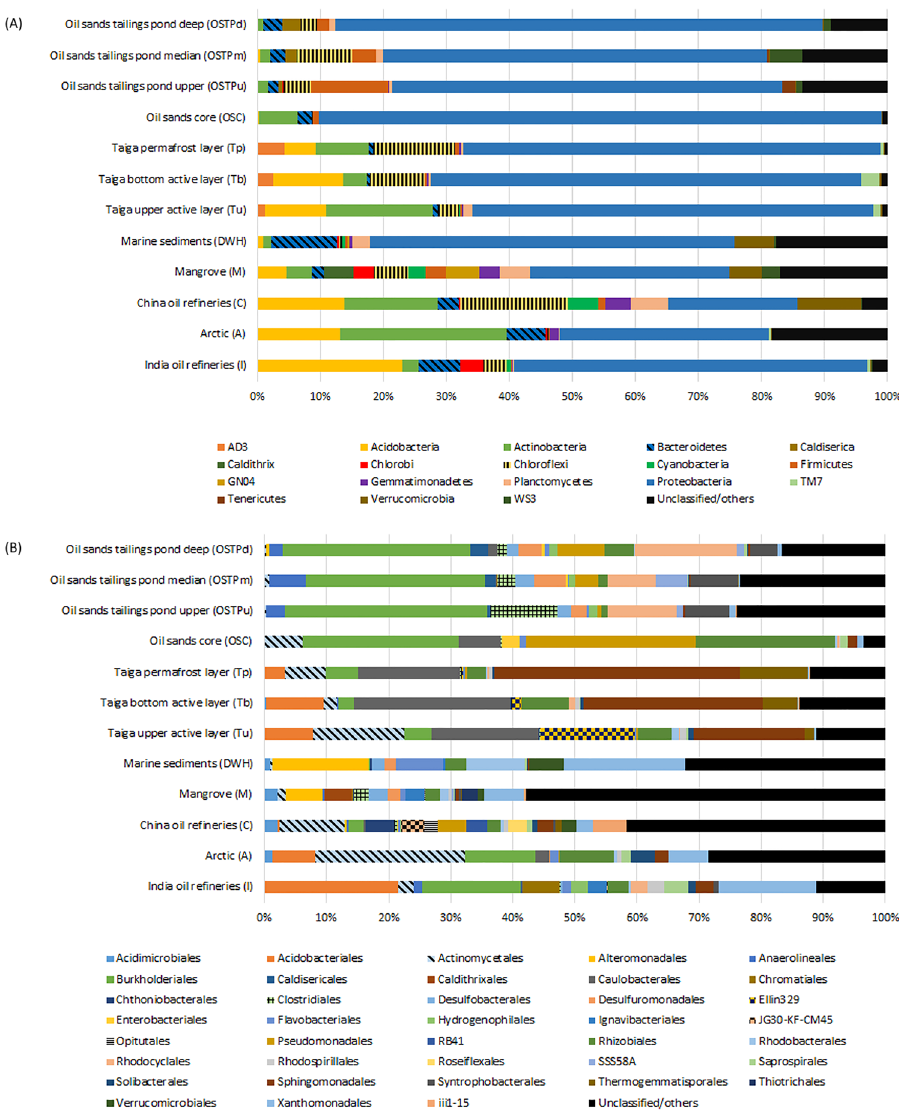
Figure 1. Taxonomic distribution of bacterial communities in oil contaminated environments. Taxonomic clades detected at an average relative abundance ≥ 2% in at least one of 12 oil contaminated habitats, ( A ) at the phylum level, and ( B ) at the order